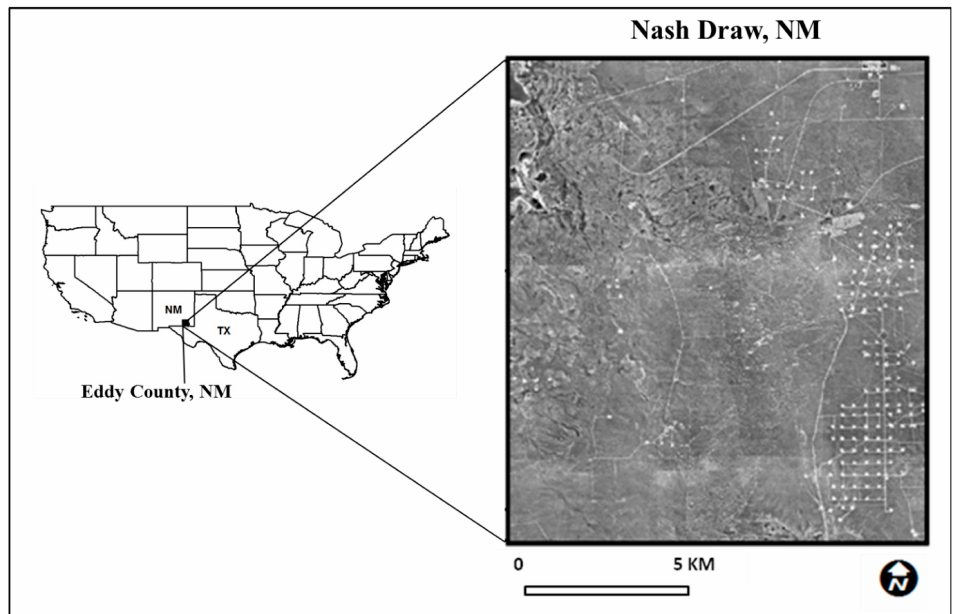
Figure 1. Location of study site.